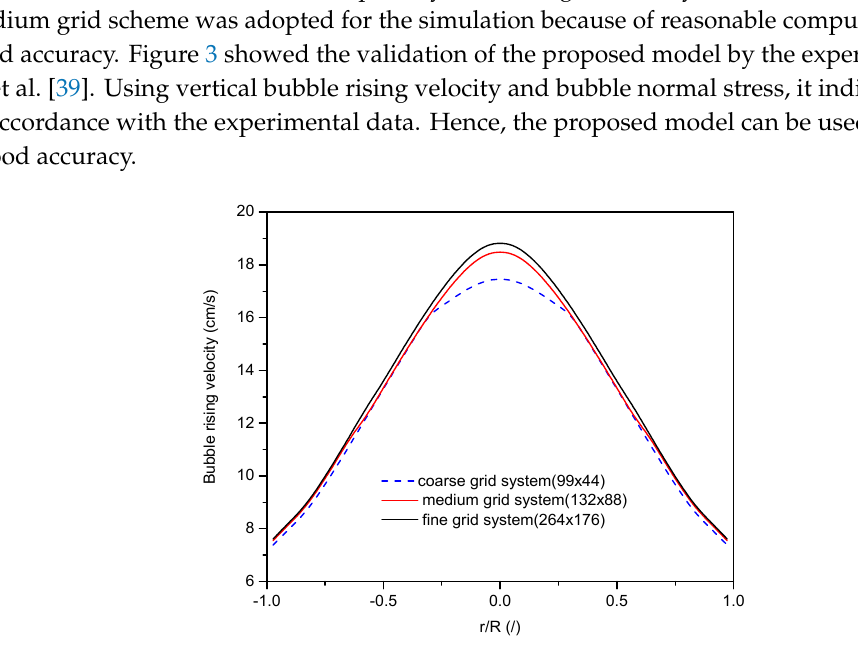
Figure 2. Validation of grid size resolution. Energies 2019 , 12 , x FOR PEER REVIEW